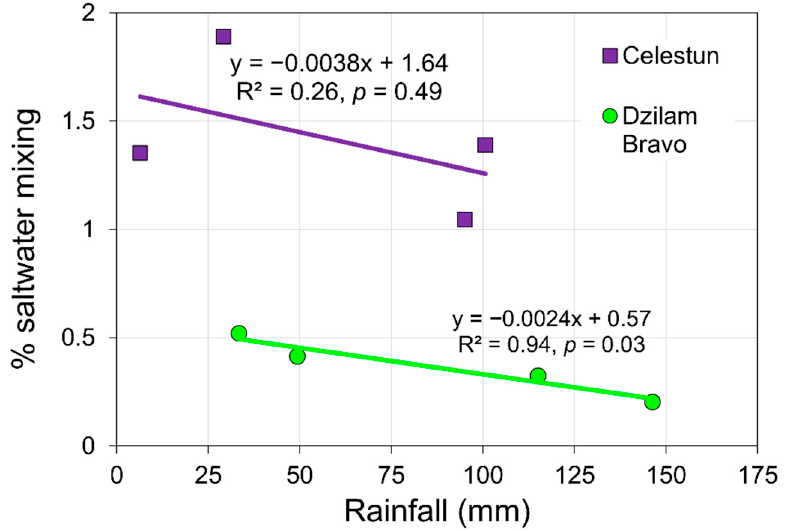
Figure 8. Relation of seawater percentage mixing and saturation index of gypsum (SI g ) with the rainfall (average the accumulated precipitation measured during each sampling period) for the Celestun trajectory, and the Dzilam Bravo trajectory.